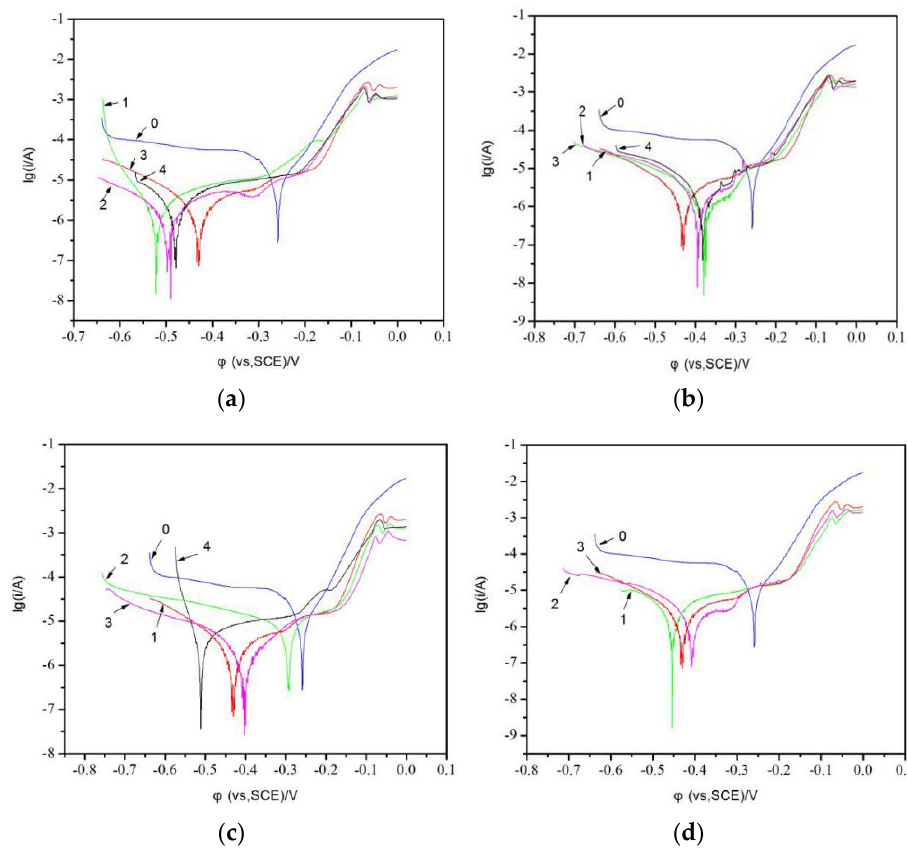
Figure 4. Plating electrochemical workstation Tafel polarization curve. (The 0 line segment of the four figures is ( a ) Tafel curve of pure copper; a showed the samples with different amounts of cerium